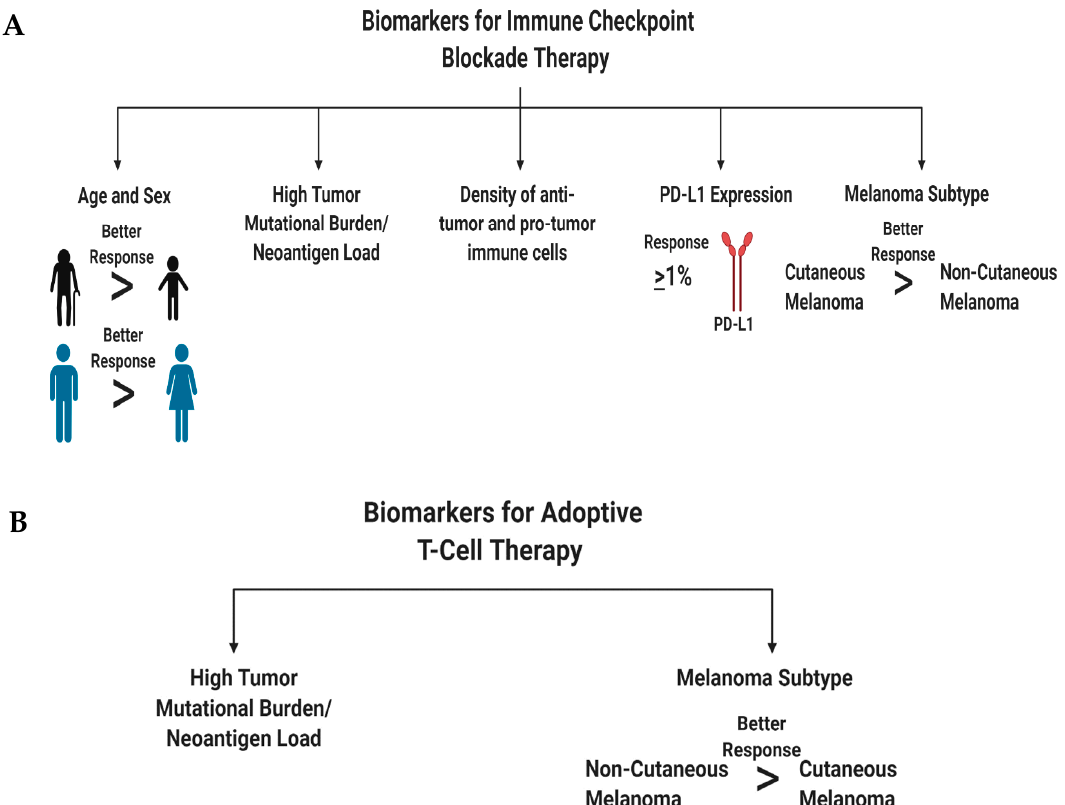
Figure 4. Biomarkers for immune checkpoint blockade therapy ( A ) and adoptive T-cell therapy ( B ) that can improve stratification of melanoma patients into responders and non-responders. Created with BioRender.com.